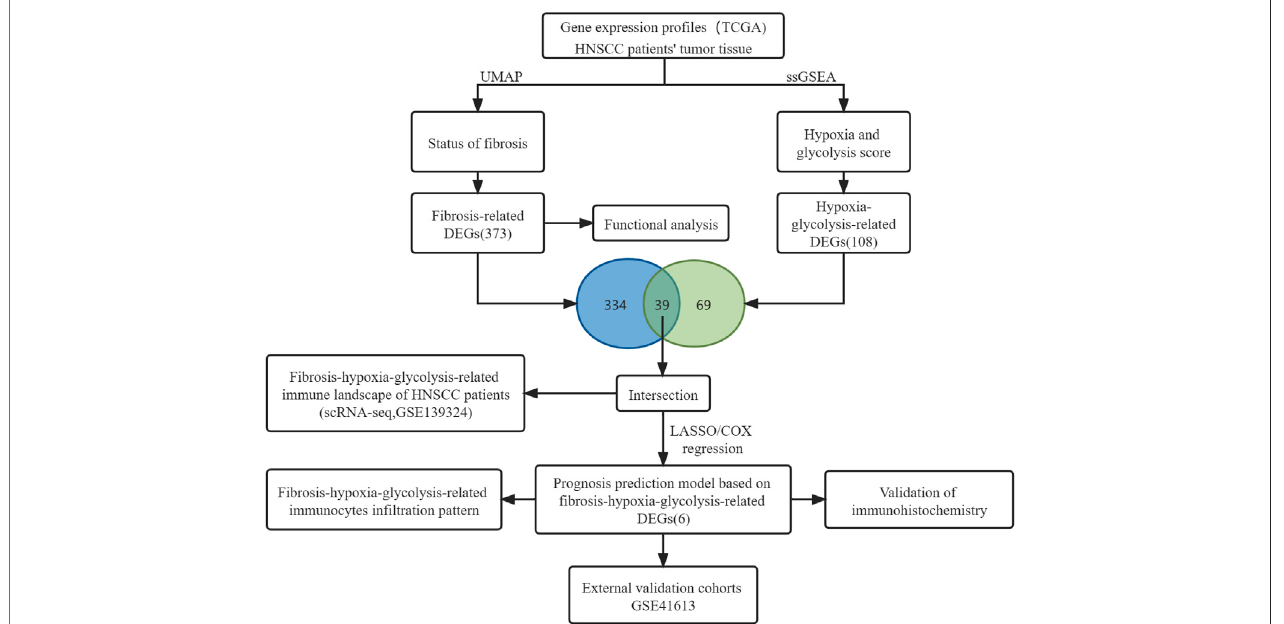
FIGURE 1 | Flowchart diagram of the